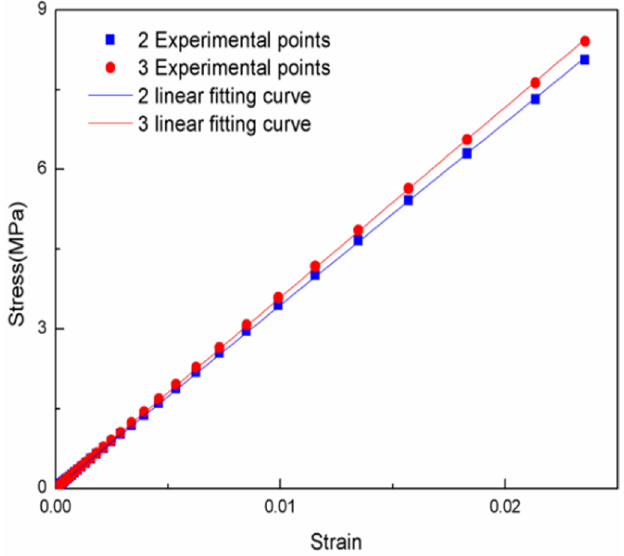
Figure 10. Stress–strain fitting curves for samples 2 and 3.